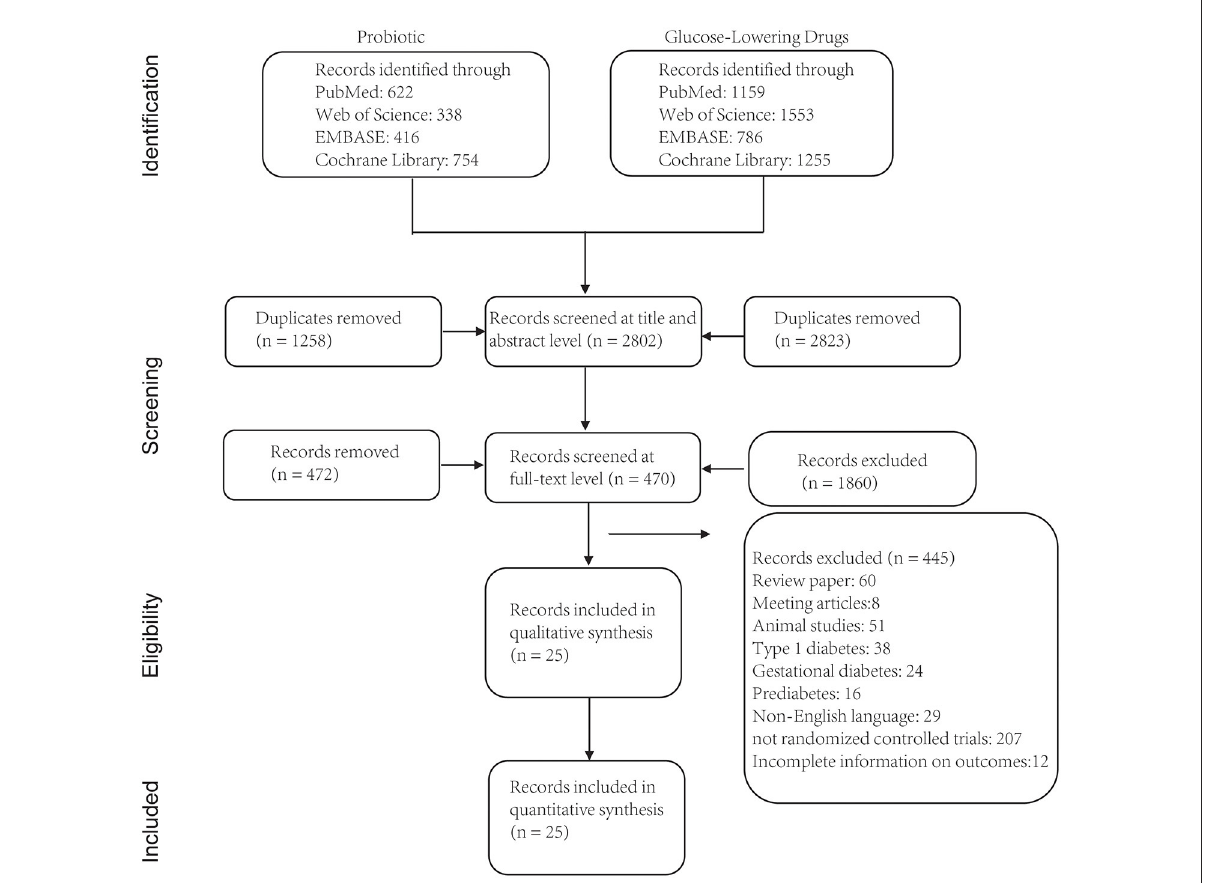
FIGURE1 Flow chart depicting the literature search and selection strategy (based on PRISMA